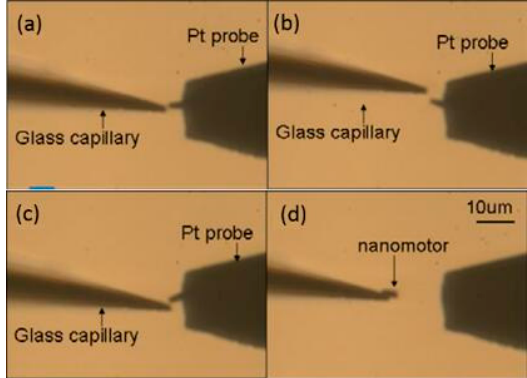
Figure 6. The cut off process of the nanorobot. ( a ) The nanorobot is in the original middle position. ( b ) The nanorobot is pressed upward. ( c ) The nanorobot is pressed downward. ( d ) The nanorobot is cut off from the Pt probe and connects to the glass capillary.